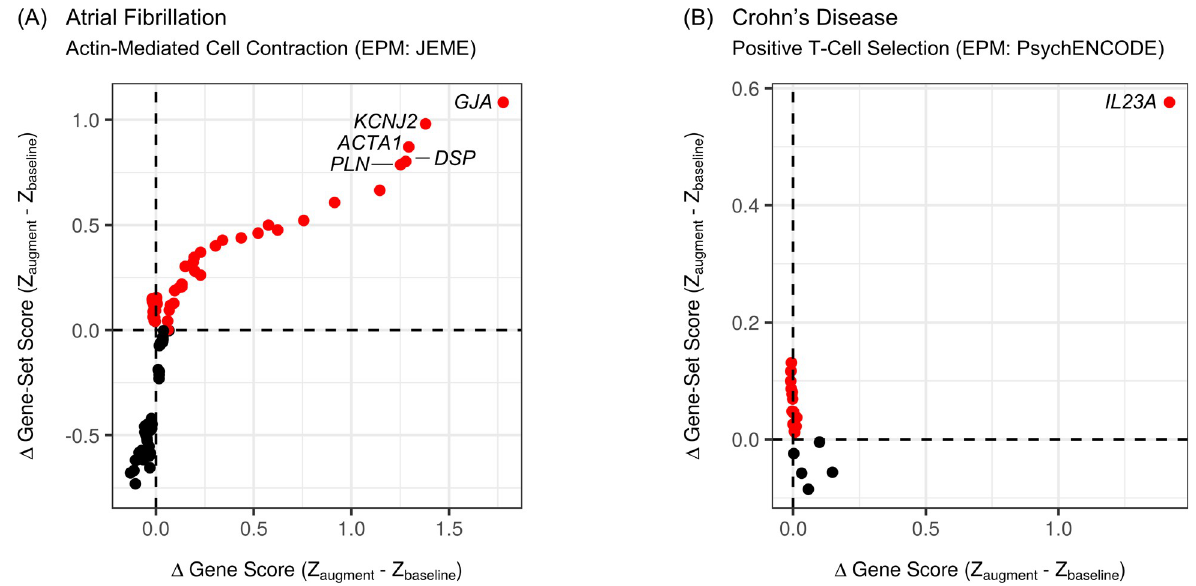
Fig 7. The IRED procedure for identifying robust gains from augmentation for gene sets. Genes were iteratively and cumulatively removed, one-by-one, from a selected gene set (beginning with the top-gaining gene, then the second-biggest gaining gene, and so forth). At each iteration, the impact on the gain of the gene set itself was inspected. One dot is shown for each iteration. Each dot represents the gene-set score difference (determined following probit transformations of one minus each FDR-adjusted, upper-tail p -value) in relation to the difference in the gene score (as used in gene-set analysis and for ranking the genes for IRED, before multiple-testing correction) of the top-gaining gene still present at an iteration. Given the nature of the procedure, progressive iterations are traced by moving from right to left on a graph. For clarity, red dots mean that the gene set demonstrates a gain from augmentation (otherwise, dots are black). The number of iterations for a gain to be lost for the first time (that is, the number of red dots before the first black dot is encountered when moving from right to left), is counted to assess robustness of a gain of a gene set. For both graphs, some top-gaining genes have been labelled for reference. (A) A robust gain ( actin-mediated cell contraction gene set detected for atrial fibrillation with augmentation from the EPM of JEME dataset of regulatory interactions). (B) A non-robust gain ( positive T-cell selection gene set detected for Crohn’s disease with augmentation from the EPM of PsychENCODE dataset of regulatory